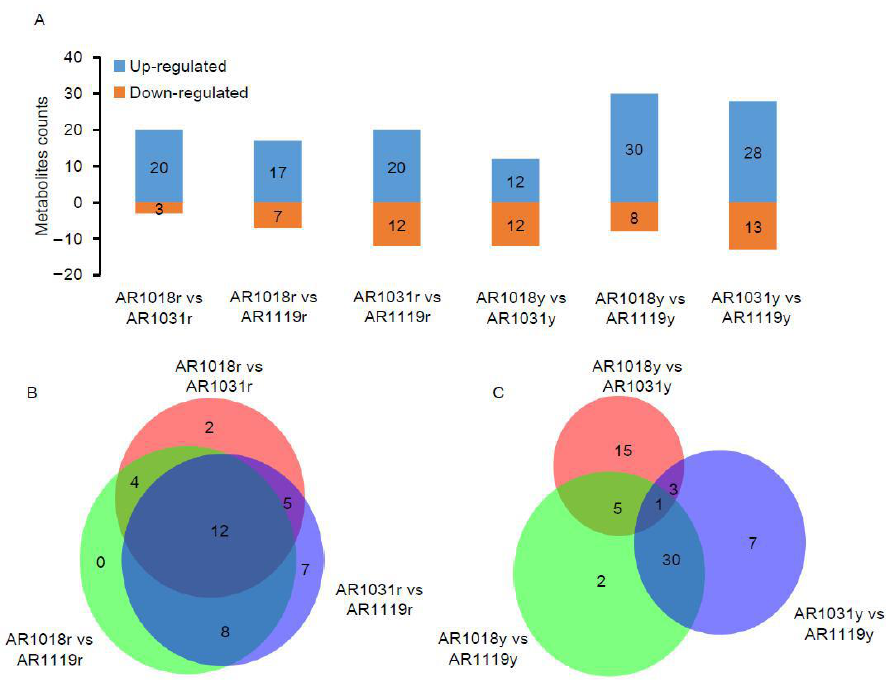
Figure 4. The differentially accumulated metabolite analysis. Note: ( A ) the number of DAMs in three groups. ( B ) Venn diagram of red-strain DAMs in three groups. ( C ) Venn diagram of yellow-strain DAMs in three groups.